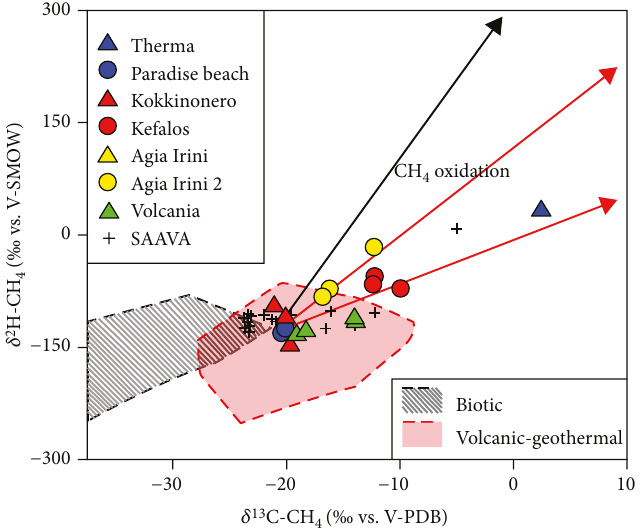
Figure 6: Modi fi ed Schoell binary diagram [65] of δ 2 H-CH and δ 13 C-CH ratios for the Hellenic gas discharges. Slopes of biogenic oxidation 4 4 are plotted as red- and black-colored lines, respectively. SAAVA data from and abiogenic oxidation of CH 4